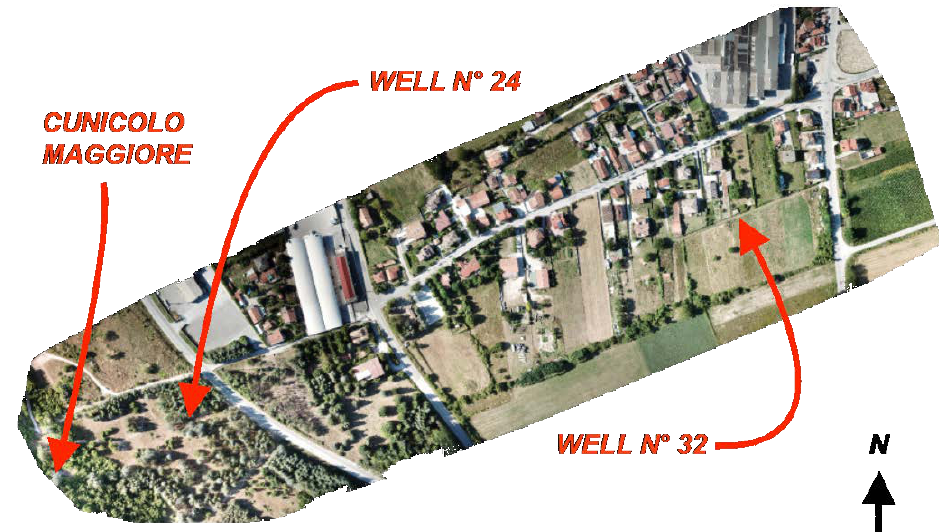
Figure 11. Point cloud resulting from photogrammetry elaboration.